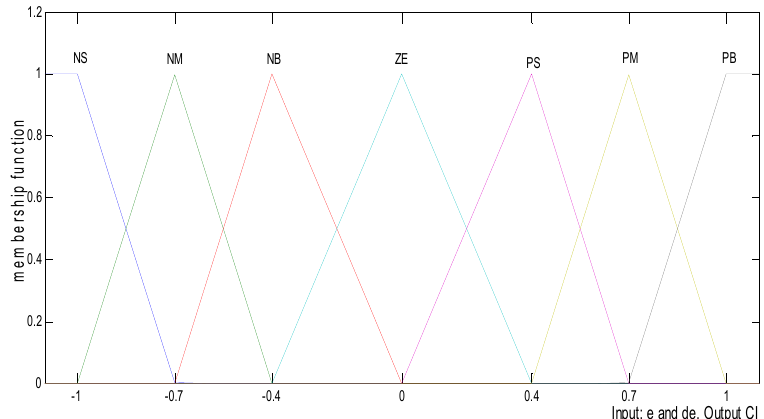
Figure 1. Triangle membership function of the fuzzification inference.